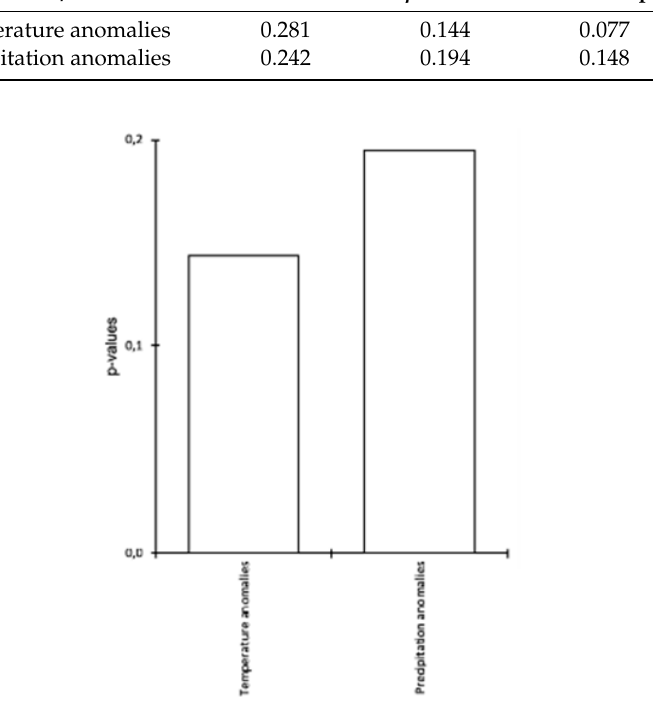
Climate 2019 , 7 , x FOR PEER REVIEW